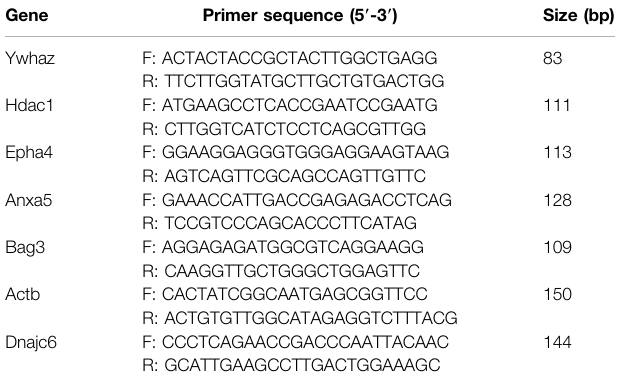
TABLE 1 | Primers for RT-qPCR. TABLE 2 | Values of RINs for the samples